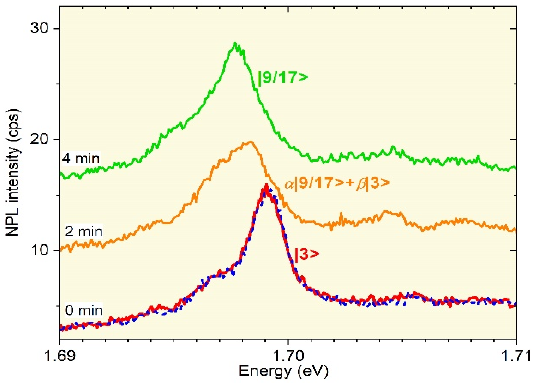
Figure A3. Spectra of D07m QD measured at B e ↓ = 5T at time delay 0, 2 and 4 minutes (solid curves) together with the spectra measured at B e ↑ = 5T ( dotted curve).